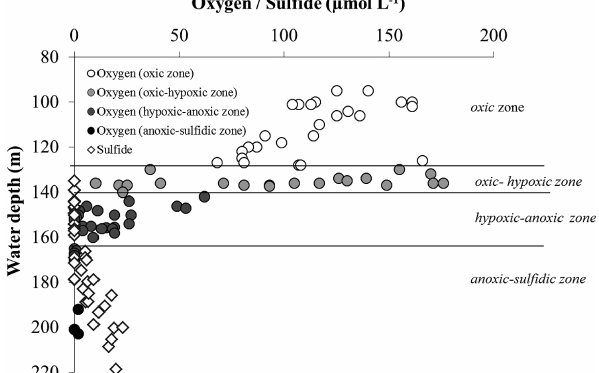
Figure 2. Synthesis of oxygen concentrations in bottom water (cir- cles) measured during the 2 weeks of the cruise ( n = 85). For con- tinuously measuring instruments (BBL profiler, optode on JAGO, benthic lander, moorings) only an average value per deployment, dive or day was included. Maximum depth above the sediment was 12m (CTD), minimum depth above the sediment was about 5cm (Clark-type oxygen microelectrodes). Additionally, sulfide distribu- tion in bottom waters during the same sampling period are shown (white diamonds; n = 43). From depth distribution of oxygen and sulfide the distribution in (i) oxic, (ii) oxic–hypoxic, (iii) hypoxic– anoxic and (iv) anoxic–sulfidic zone was deduced.